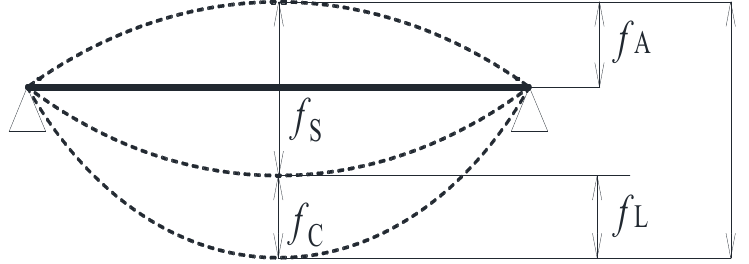
Figure 10. Diagram of the typical creep curve.